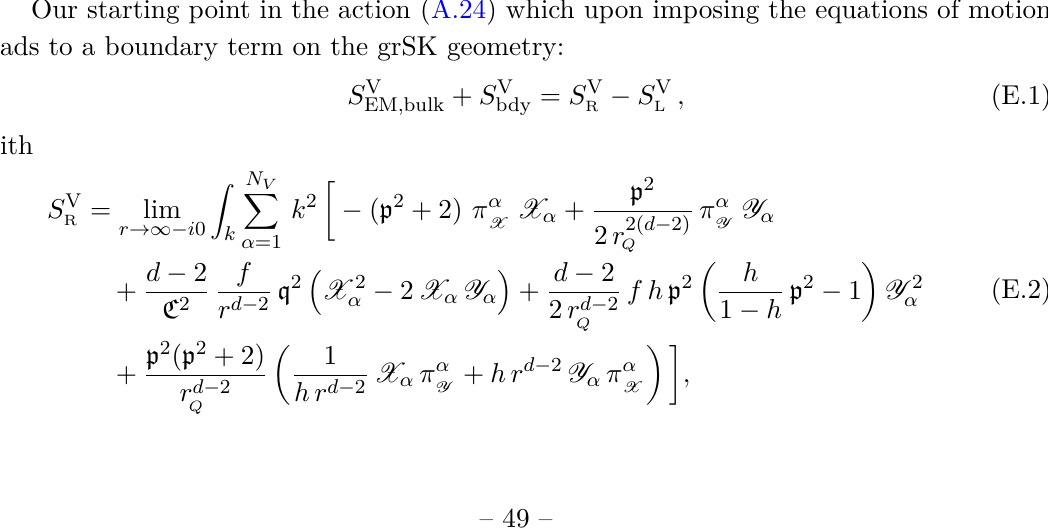
for various dimensions, sup- α